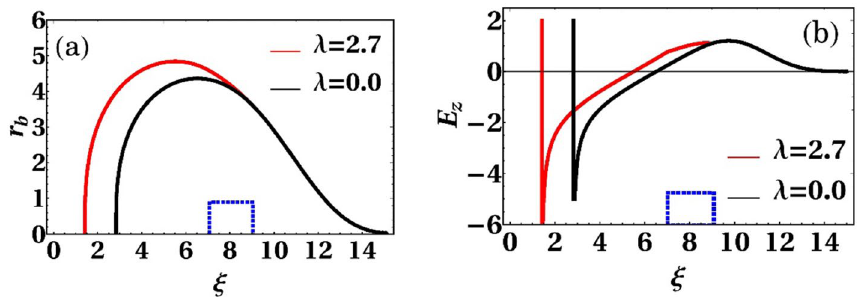
Figure 1. ( a ) Shape of the bubble and ( b ) the corresponding wakefields for maximum blowout radius, r b = 4 (black), and a hybrid laser pulse with maximum blowout radius, r b = 4 and bi-flat-top electron beam with λ = 2.7 (red). The electron beam is located at 7 ≤ ξ ≤ 9 (blue